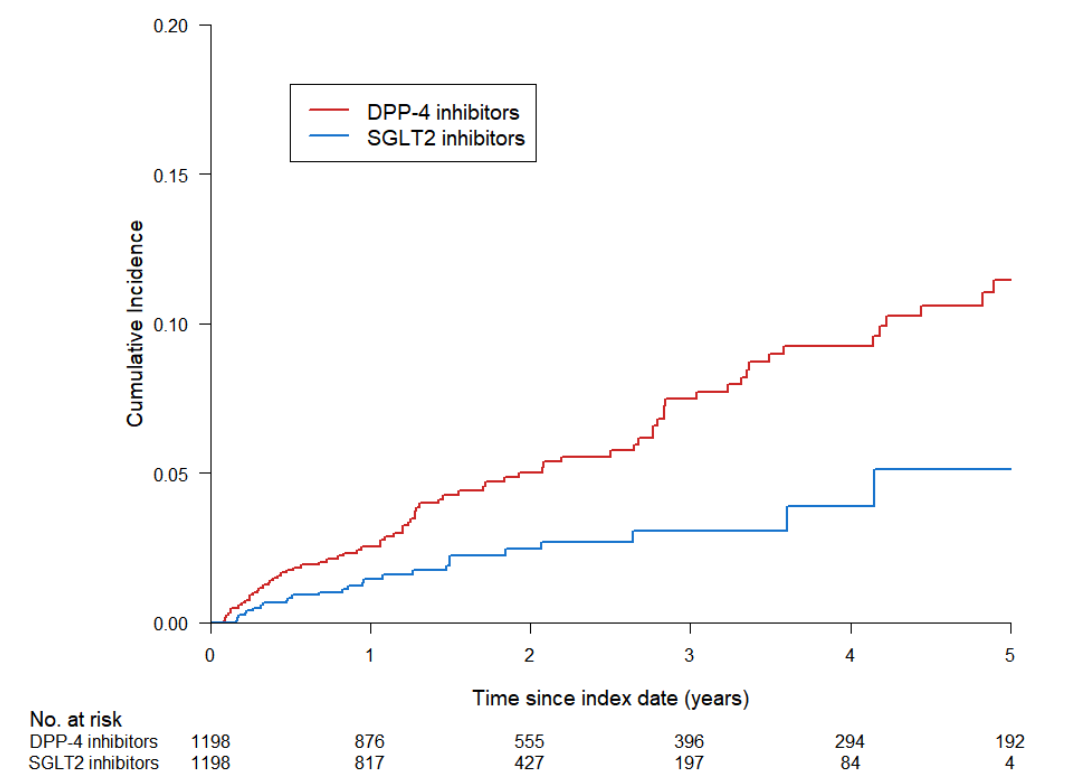
Figure 2. Comparison of cumulative incidence of renal events (eGFR < 45 mL/min/1.73 m 2 ) in matched cohort between SGLT2 inhibitors group and DPP-4 inhibitors group. eGFR, estimated glomerular filtration rate; SGLT2, sodium–glucose cotransporter-2; DPP-4, dipeptidyl